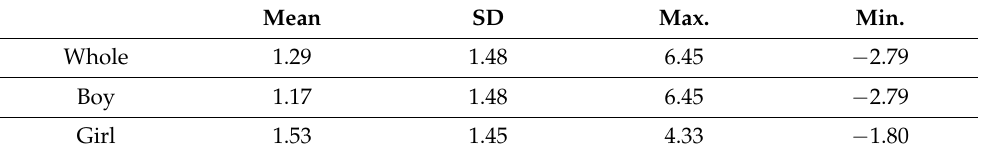
Table 1. Leeway space (mm) for all children and boy and girl groups. Mean SD Max. Min.